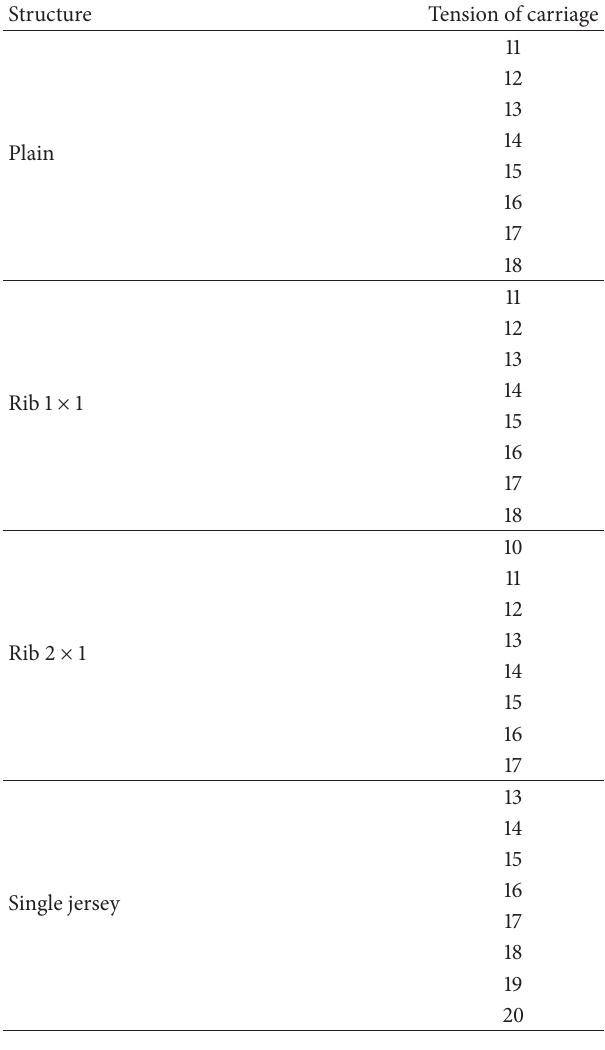
Table 1: Knitted samples fabric produced from varying the stitch cam value.